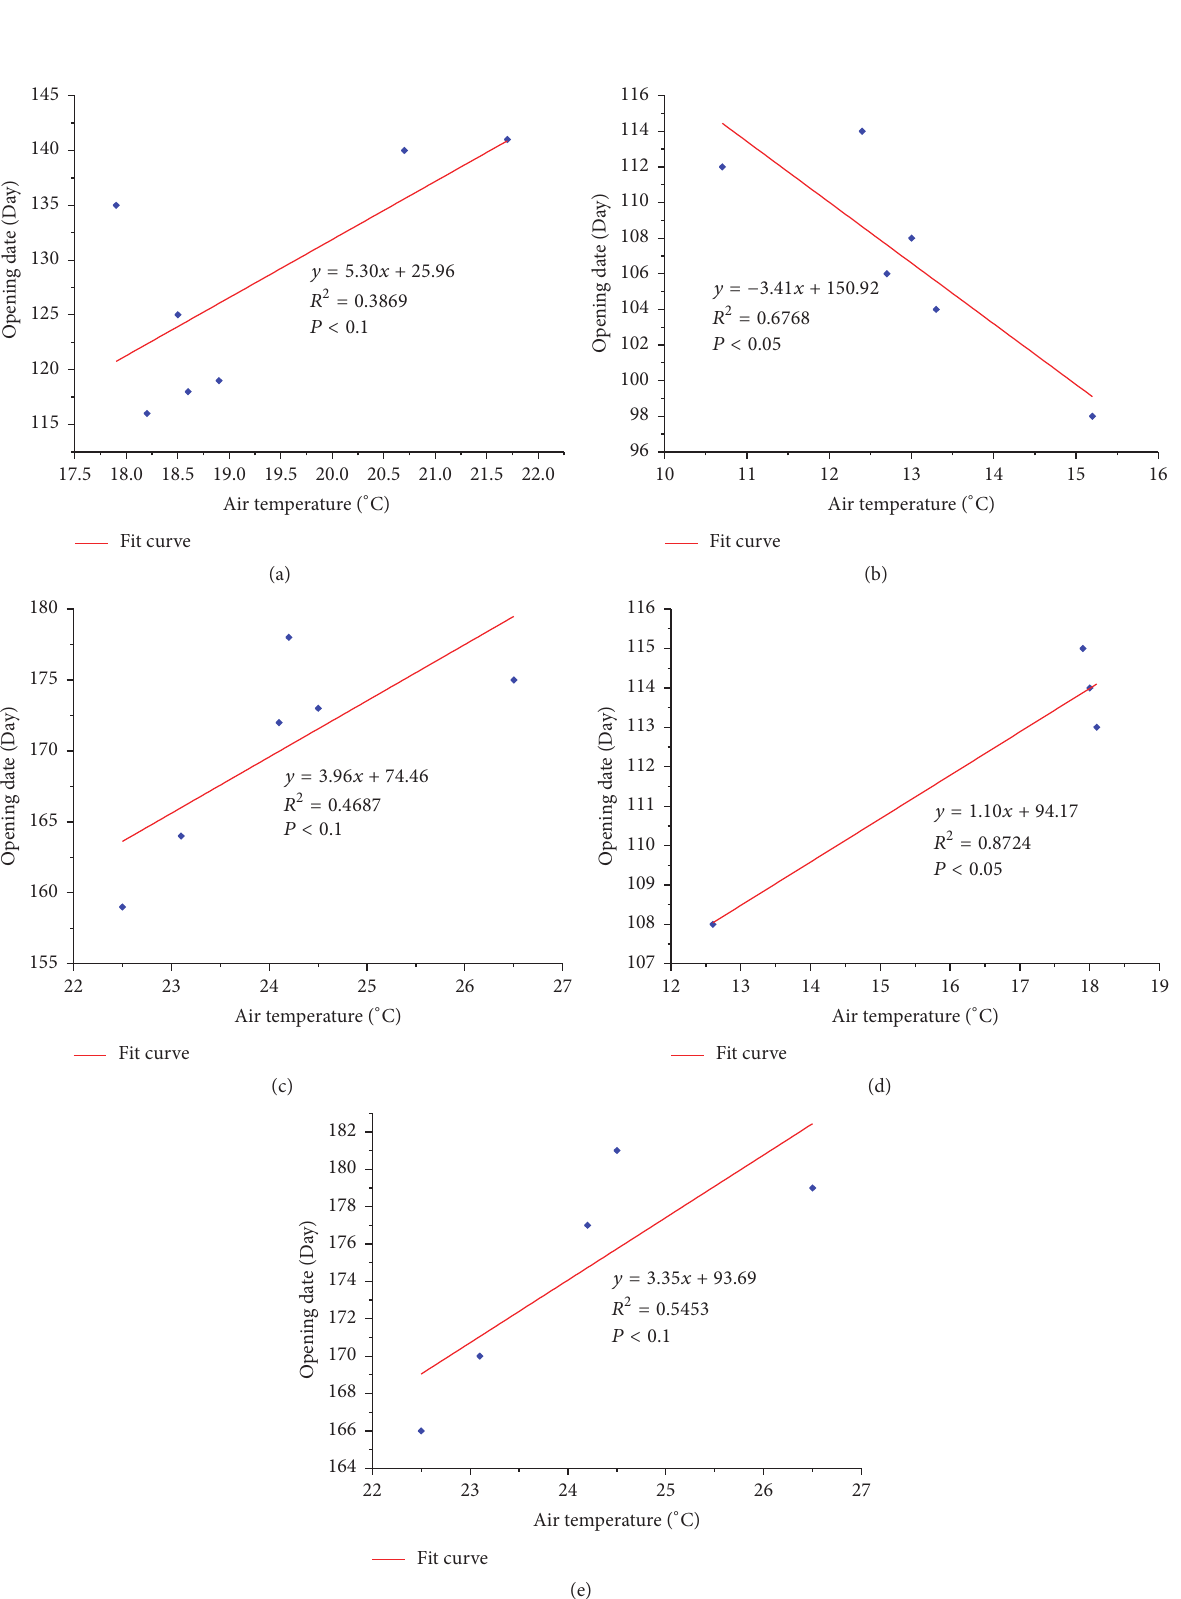
Figure 4: Response relationship between picking tourism festival open date and air temperature in